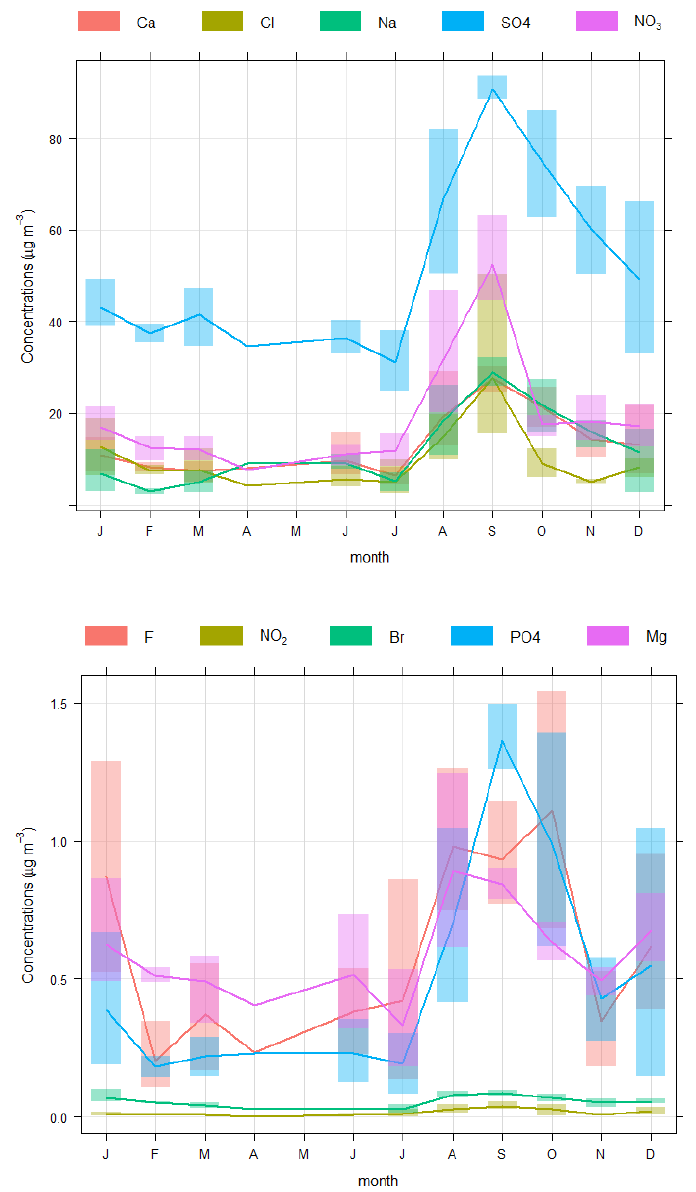
Figure 3. Annual cycles of PM 10 ( upper panel), major ions, namely Ca, Cl, Na, SO 4 , and NO 3 ( middle panel), and minor ions, namely F, NO 2 , Br, PO 4 , and Mg ( lower panel) concentrations at Aziziyah site during the study period. In April, data were available only for one week and in May, no data was available, therefore for April, only mean concentration is shown without confident interval and for May, the concentration is not shown at all.